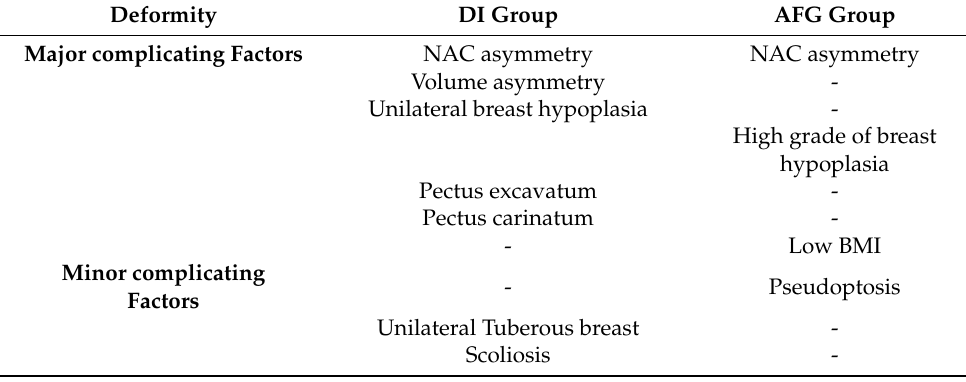
Table 3. Complicating factors